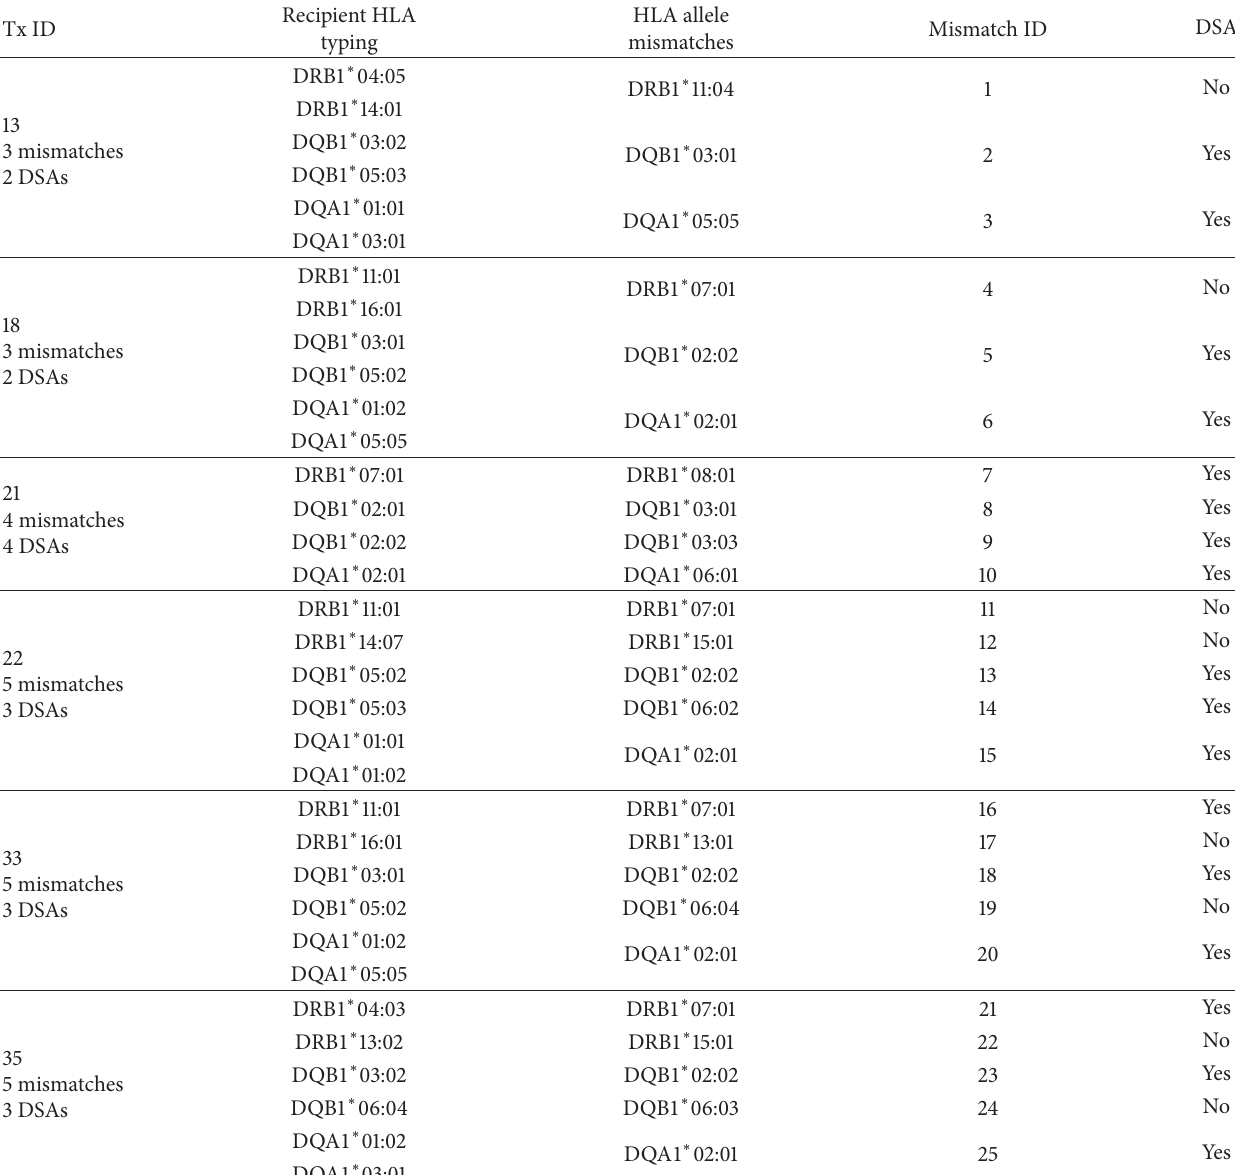
Table 1: Transplant cases: HLA-DR and HLA-DQ mismatches and